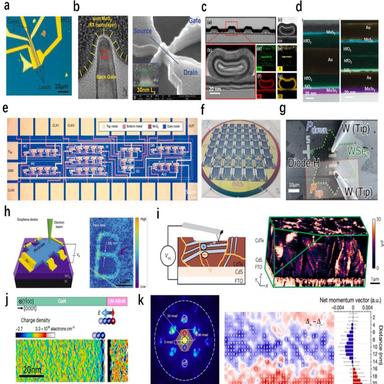
2D electronic device architecture and novel microscopy characterization methods. a. OM image of the first MoS2 transistor (. Copyright (2011), with permission from Springer Nature Ltd. b. TEM and SEM image of MoS2 body on MoS2 FinFET with Si back gate (. Copyright (2015), with permission from IEEE. c. TEM and EDS mapping of cross-sectional monolayer MoS2 nanosheet device with gate stack fully wrapped around the channel (Chung et al., 2022). Copyright (2024), with permission from IOP Pu